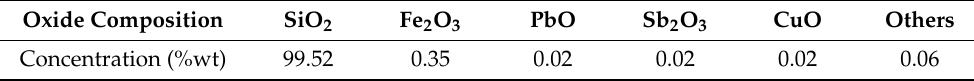
Table 4. Oxide composition of geothermal